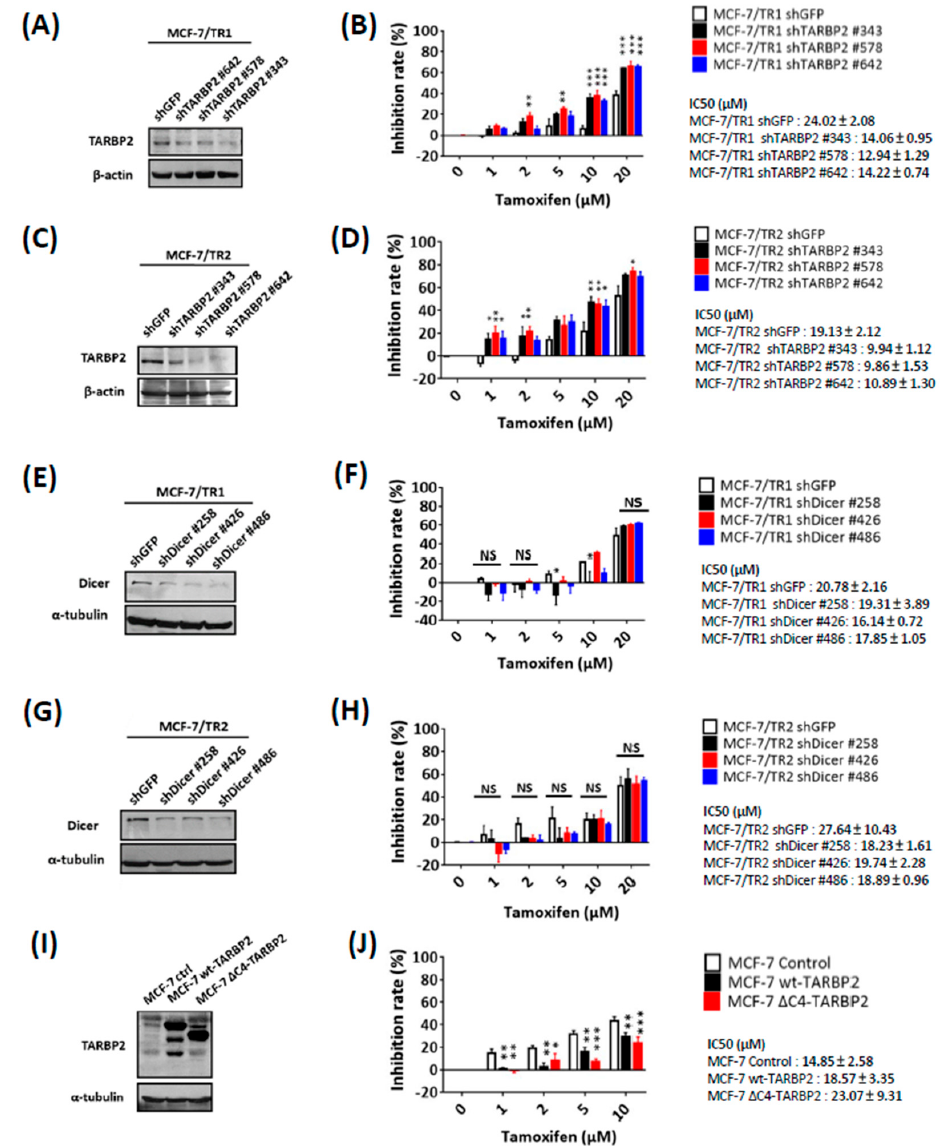
Figure 2. TARBP2 confers tamoxifen resistance in breast cancer cells through a Dicer-independent pathway. ( A – D ) Effect of TARBP2 in tamoxifen resistance. MCF-7/TR1 ( A ) and TR2 ( C ) cells were